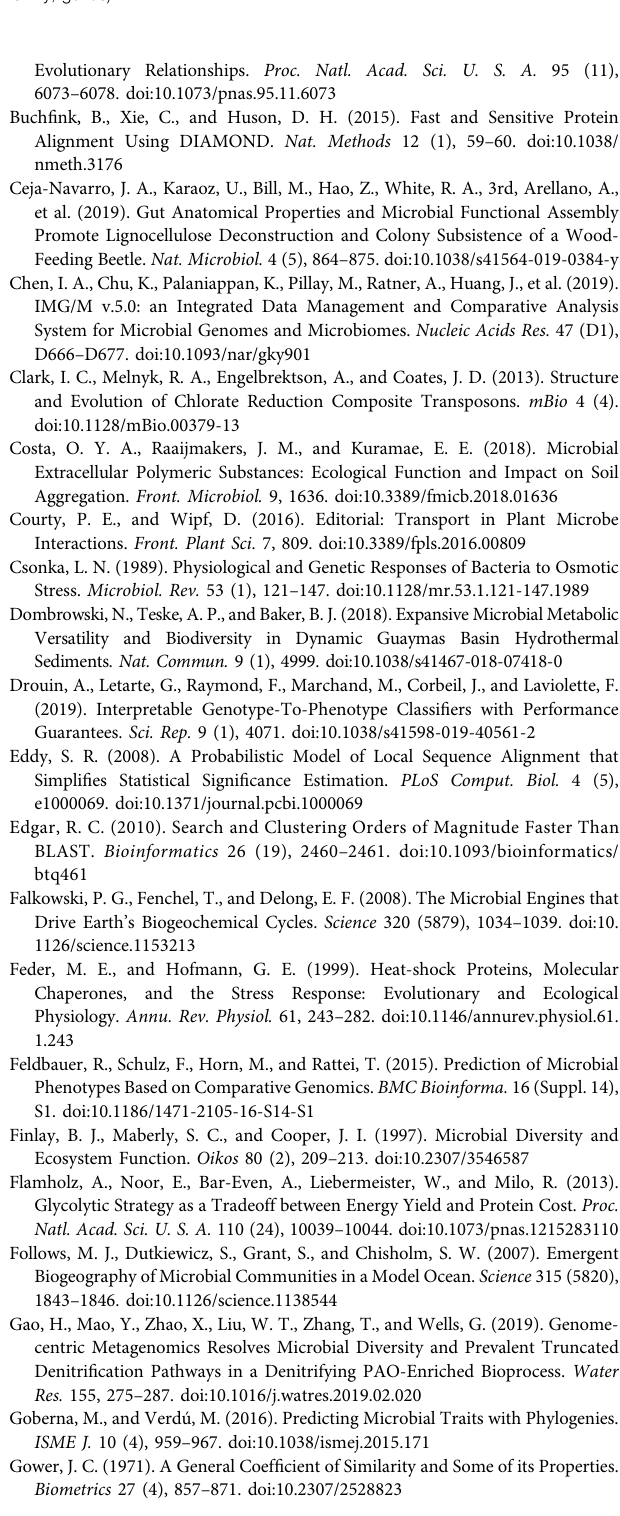
Supplementary Table S17 | Guild taxonomic pro fi les. Taxonomic pro fi les for de fi ned guilds as relative abundance of genome taxonomy (phylum, class, order, family,